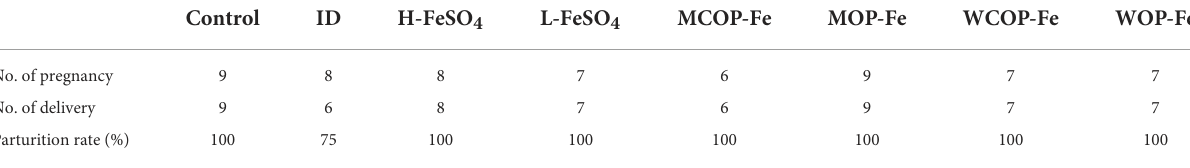
TABLE 4 Pregnancy outcome of maternal rats.